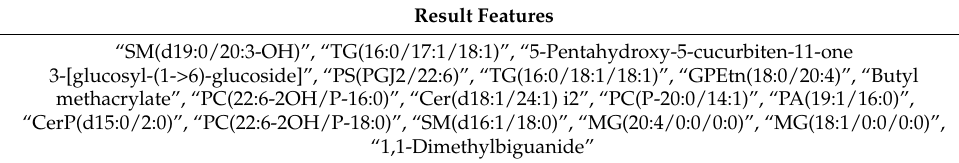
Figure 13. Evolution of maximum fitness scores over generations, using the Control-DN dataset. The vertical axis represents the fitness score, while the horizontal axis represents a given generation. The solid blue line represents the average fitness across all models. The average unfinished fitness plotted as a solid cyan line represents the average worst case expectation for all failed searches in a given generation. The red dotted line shows the established GA goal fitness. Table 10. Features obtained by GALGO NEARCENT method in the T2DM-DN